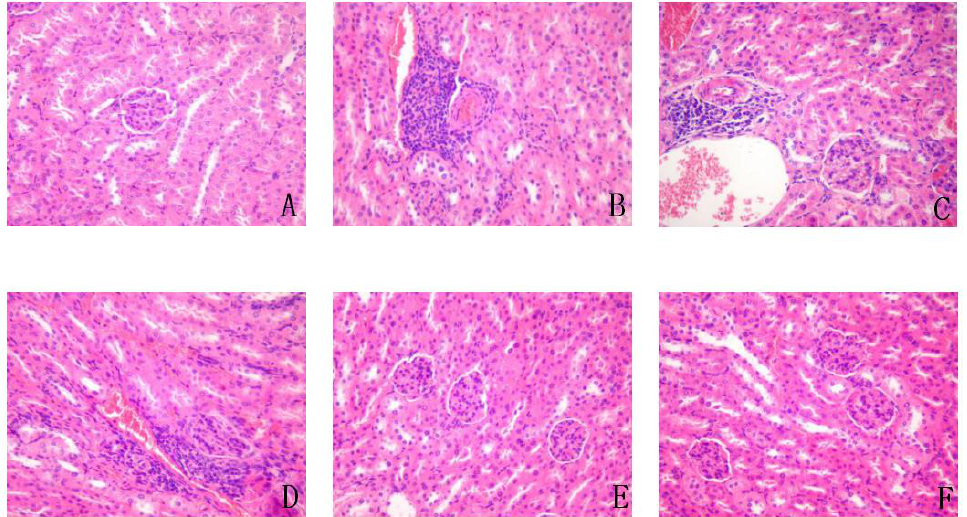
Figure 10. Representative H&E staining sections of kidneys from mice in the different groups (×200). ( A ). control; ( B ). T2DM mice; ( C ). YA 5 mg/mL; ( D ). YA 10 mg/mL; ( E ). YA 20 mg/mL; ( F ). DMBG 100 mg/mL.